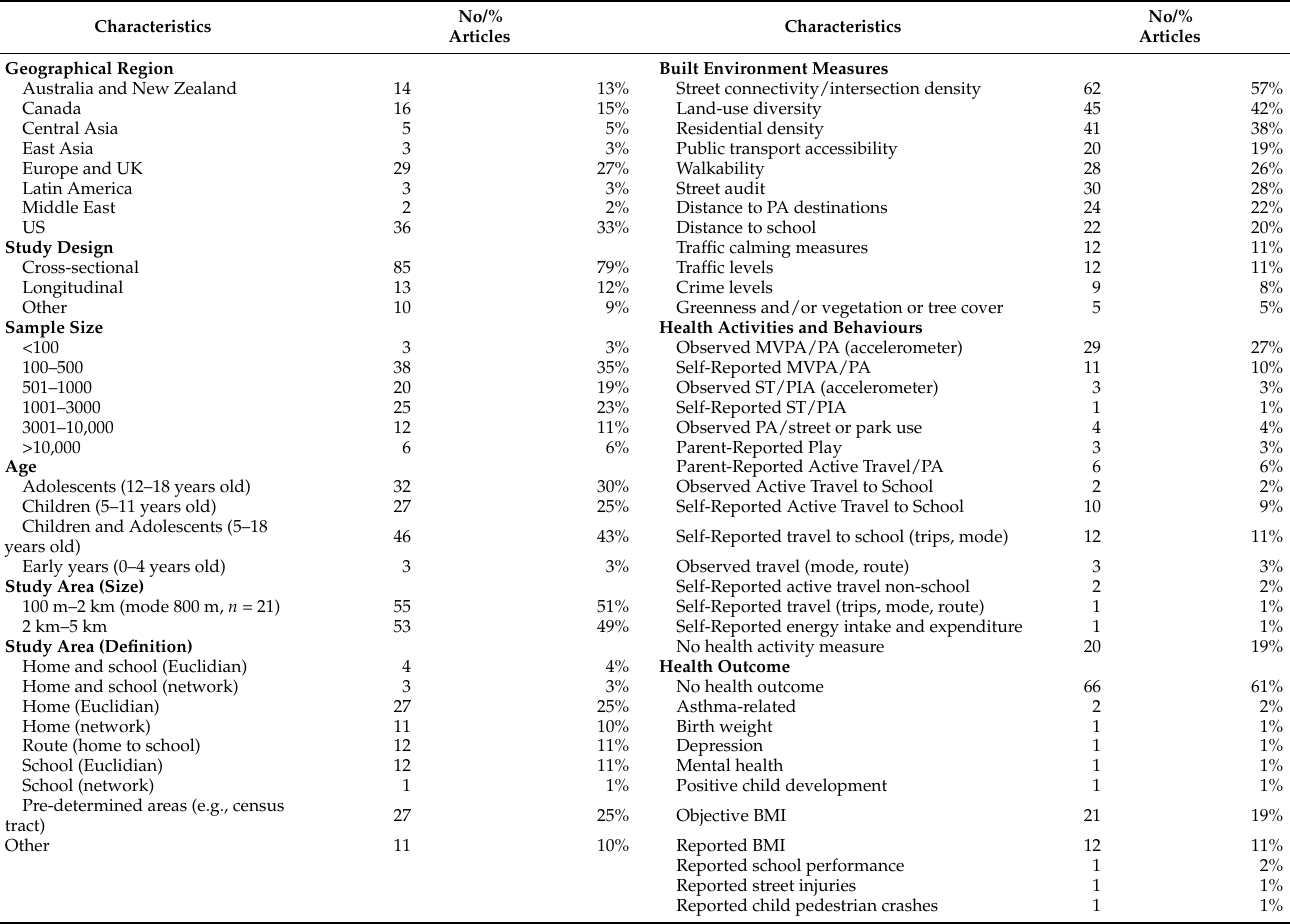
Table 1. Characteristics of selected studies ( n =